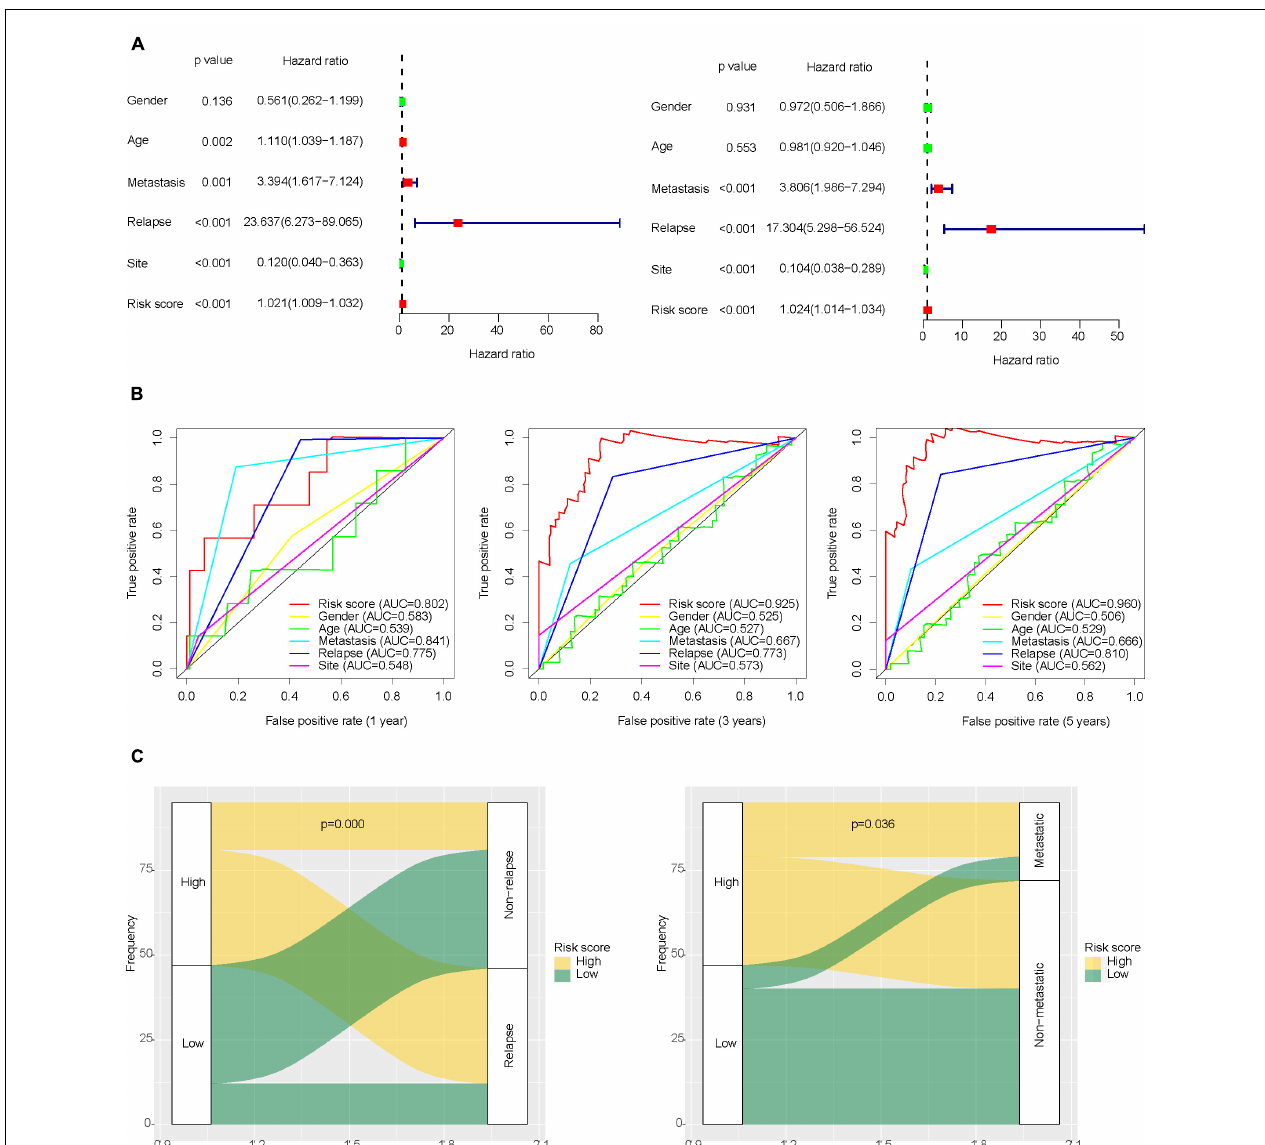
FIGURE 3 | Role of clinical features in the prognosis of osteosarcoma. (A) Univariate and multivariate Cox regression analysis of clinical features of osteosarcoma. (B) ROC curve for predicting the prognosis of osteosarcoma based on risk score and clinical features of osteosarcoma. (C) Differences in metastasis and recurrence rates between the high-risk group and low-risk